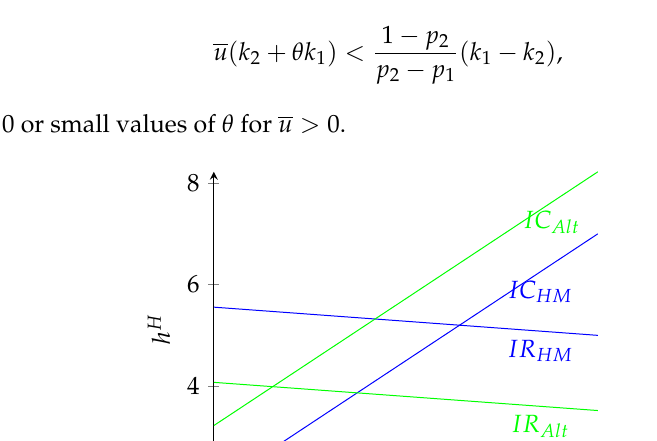
Figure A1. Optimal contracts for p 2 Figure A.2: Optimal contracts for p 2